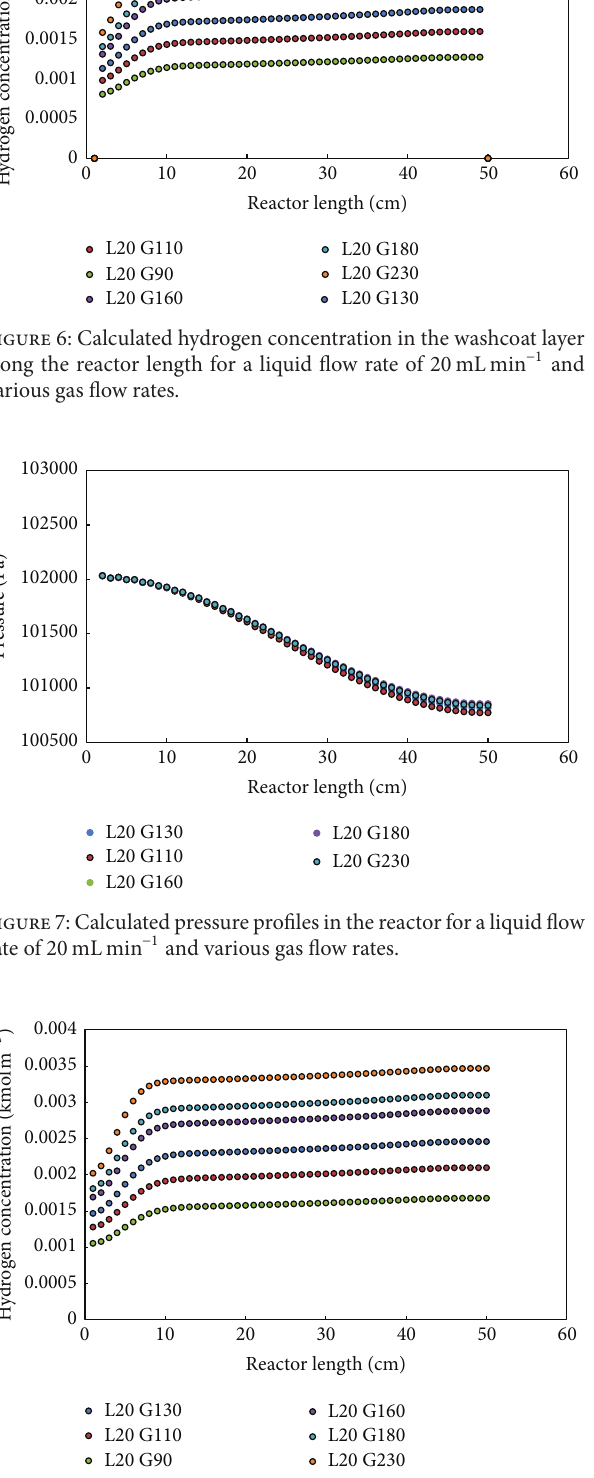
Figure 8: Calculated concentrations of hydrogen in the liquid phase along the reactor for a liquid flow rate of 20 mL min −1 and various gas flow rates.